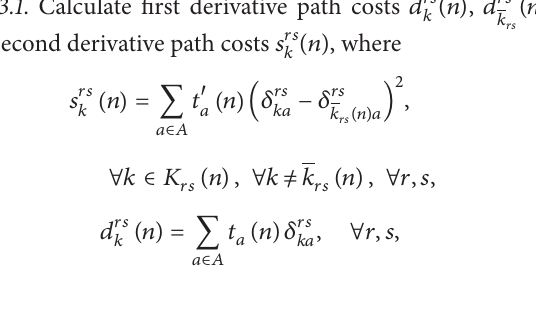
algorithm to solve the low-level model. The following is a step-by-step description of the procedure for the pGP algorithm